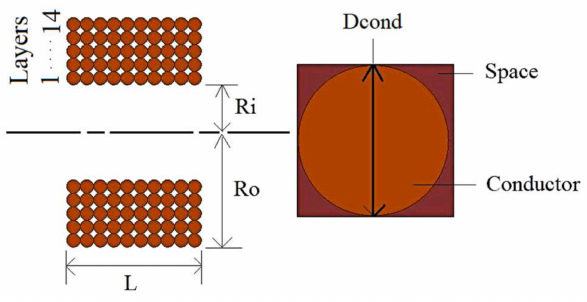
Figure 8. Winding parameters for resistance calculation for HV